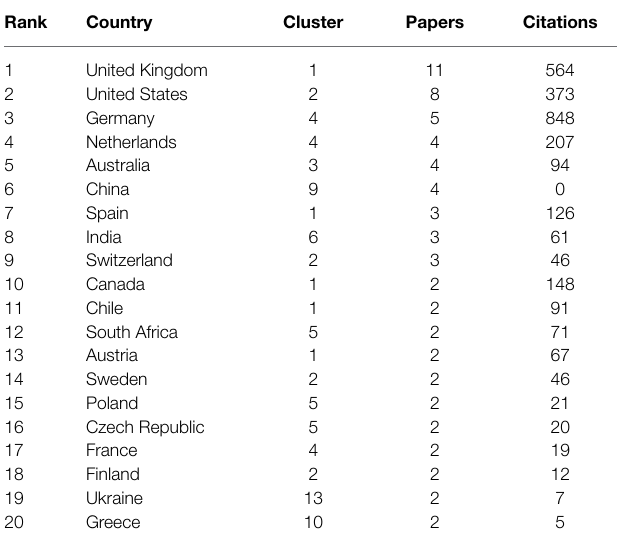
TABLE 3 | Twenty most productive countries in relation to neuroentrepreneurship research, 1999–2021 (documents ≥